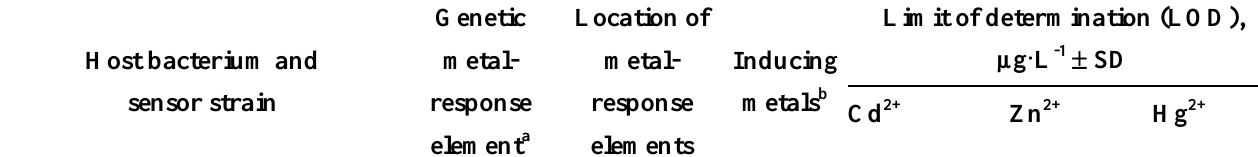
Table 1. Recombinant bacterial strains used in this study and their inducibility with heavy